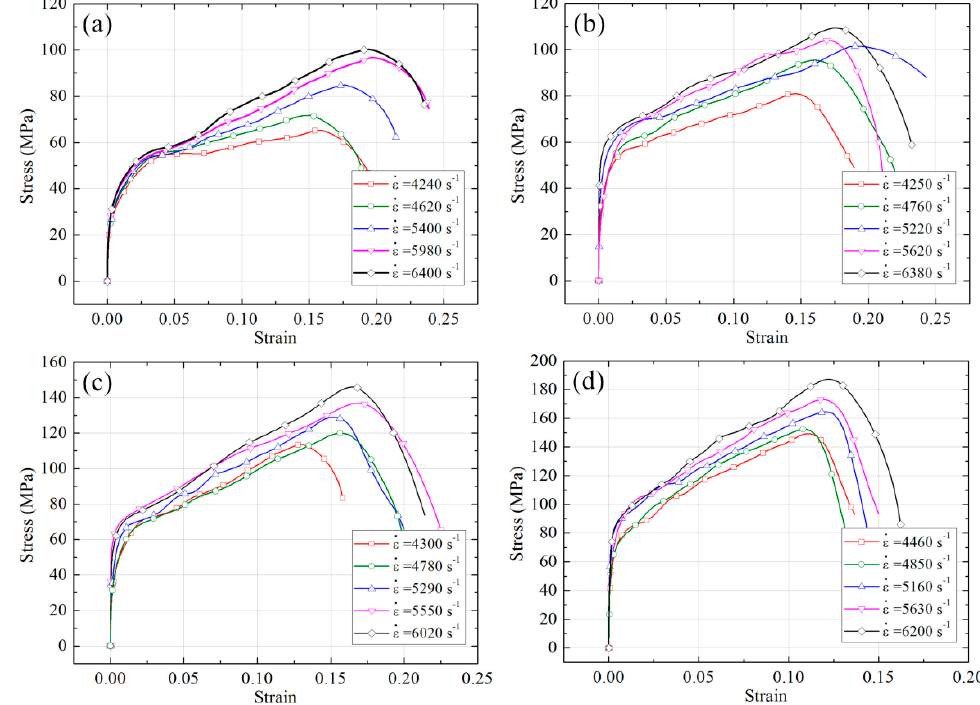
Figure 7. True stress-strain curves of PTFE/Ti/W composites under dynamic compression: ( a ) 68PTFE/32Ti; ( b ) 47PTFE/23Ti/30W; ( c ) 34PTFE/16Ti/50W; ( d ) 20PTFE/10Ti/70W. Table 2. Mechanical parameters of PTFE/Ti/W composites at different strain rates